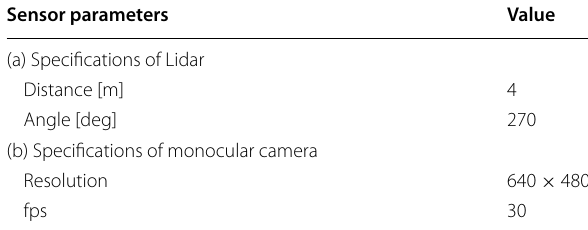
Table 1 The specifications of sensors used for simulation Sensor parameters